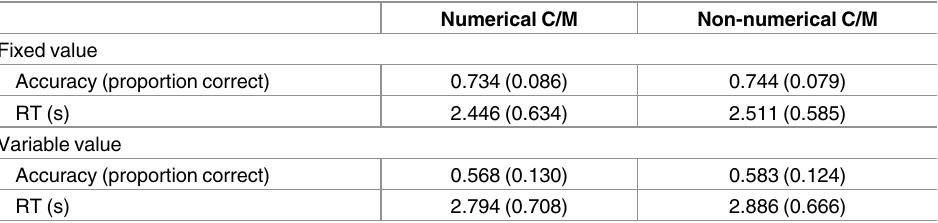
Table 4. The mean (and standard deviation) of accuracyand reaction times (RT) in